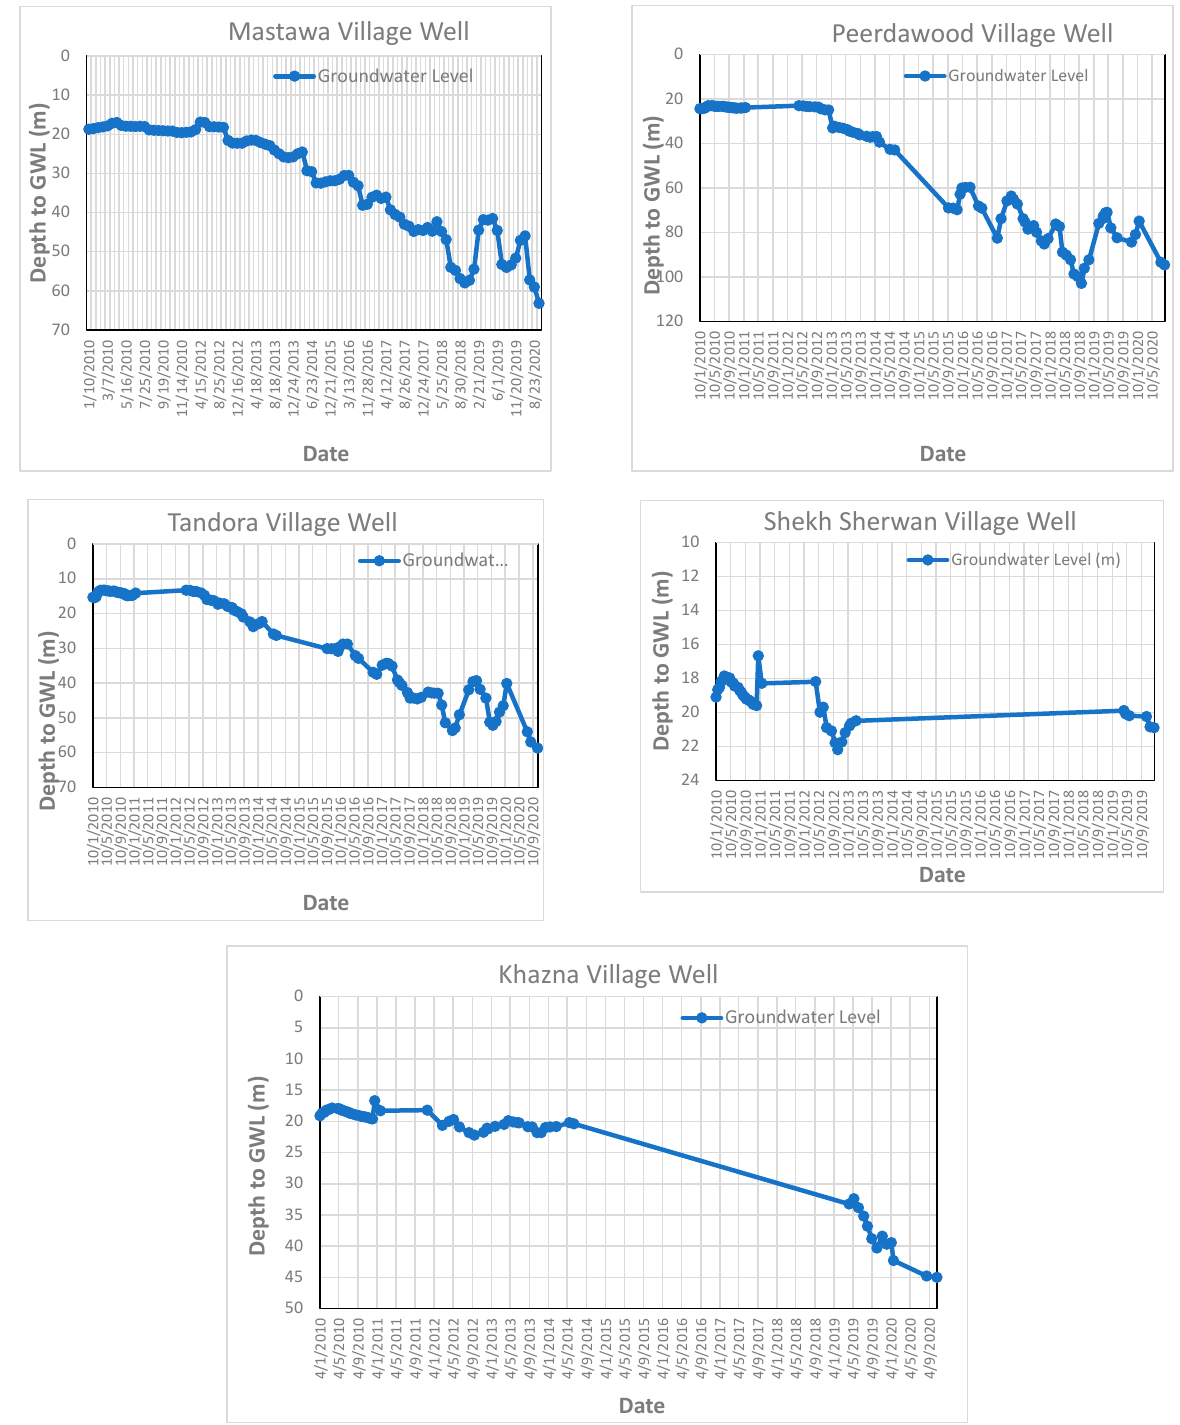
Figure A5. Groundwater level fluctuation curve in some of monitored wells.